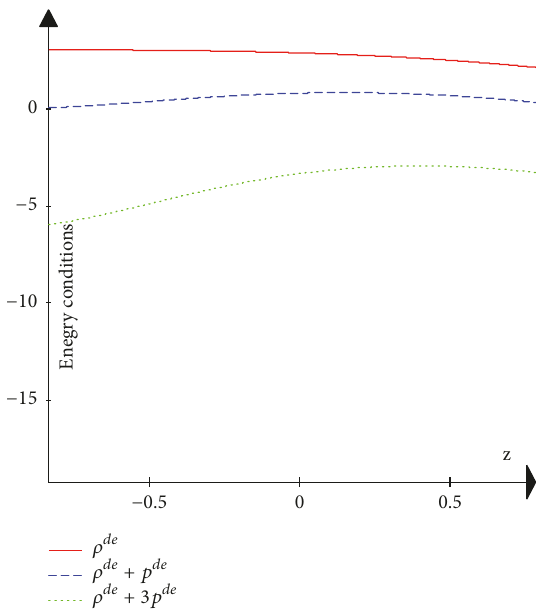
Figure 7: The plot of the weak 𝜌 𝑑𝑒 ≥ 0 , dominant 𝜌 𝑑𝑒 + 𝑝 𝑑𝑒 ≥ 0 , and strong 𝜌 𝑑𝑒 + 3𝑝 𝑑𝑒 ≥ 0 energy conditions versus redshift 𝑧 for non-interacting scenario.